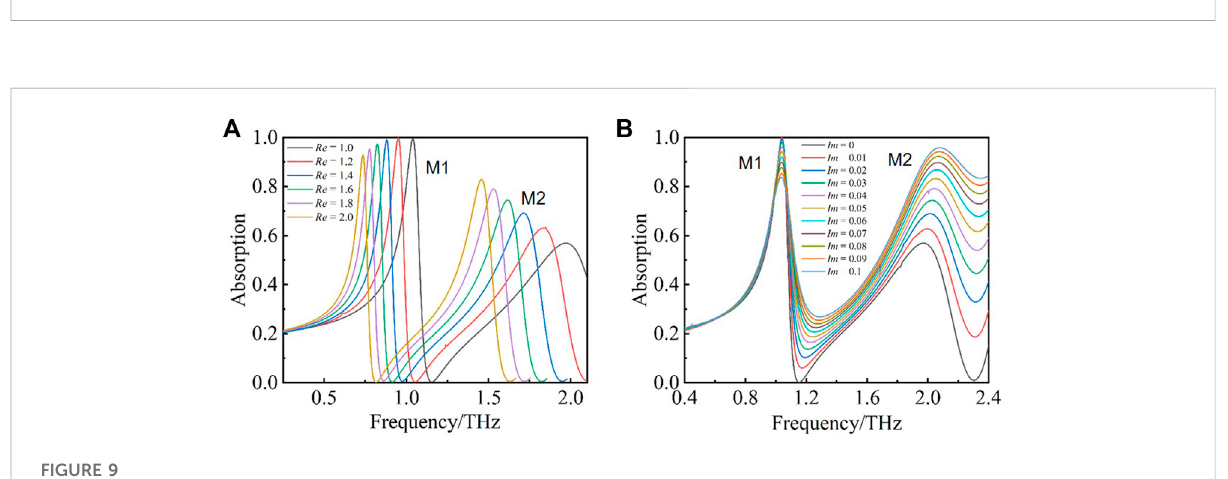
FIGURE 8 (A) Color graph of graphene-based THz metasurface sensor as the change of air layer. (B) Line graph of maximum absorption and resonant frequency of the absorption lines corresponding to h 2 from 0 ° to 50 ° . (C) (D) Line graph of frequency shift sensitivity of resonance peak M1 and M2 corresponding to Re from 1 to 2.